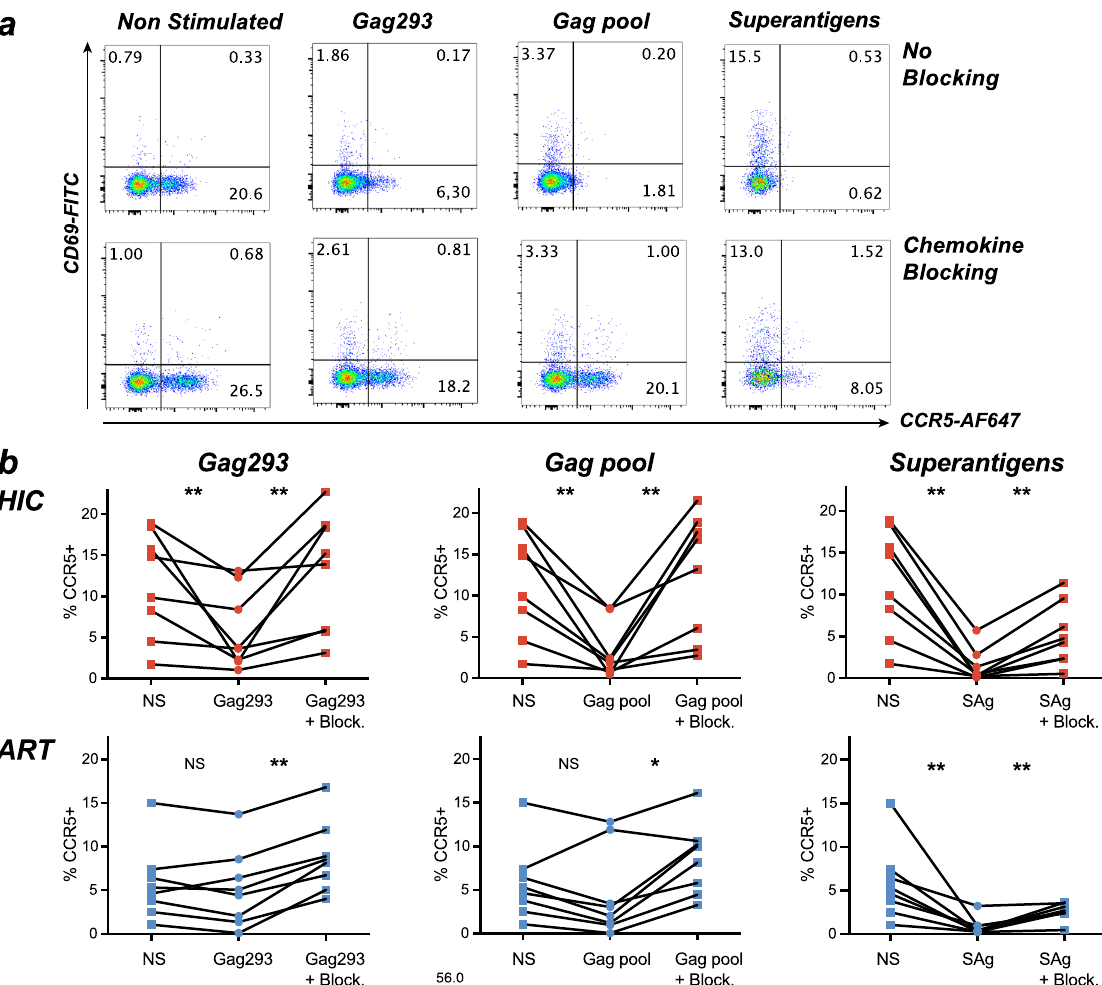
Fig. 7 Downregulation of CCR5 via β -chemokine production upon antigenic stimulation. a , b Analysis of CCR5 expression in patient memory CD4 + T cells stimulated with Gag peptides or superantigens. a Example shown for one controller: CCR5 and CD69 expression were measured in CD45RA − CD4 + T cells after a 3-day stimulation of CD8-depleted PBMC with Gag293, a Gag peptide pool, or superantigens, in the absence (top) or presence (bottom) of β -chemokine blocking antibodies. b Quantitation of CCR5 expression in memory CD4 + T cells of HIC (top) and ART (bottom) without stimulation (NS) or post-stimulation, in the absence or presence ( + Block.) of blocking β -chemokine antibodies. Variations in % CCR5 + cells were analyzed with the Wilcoxon matched-pairs signed-rank test: * P < 0.05; ** P <